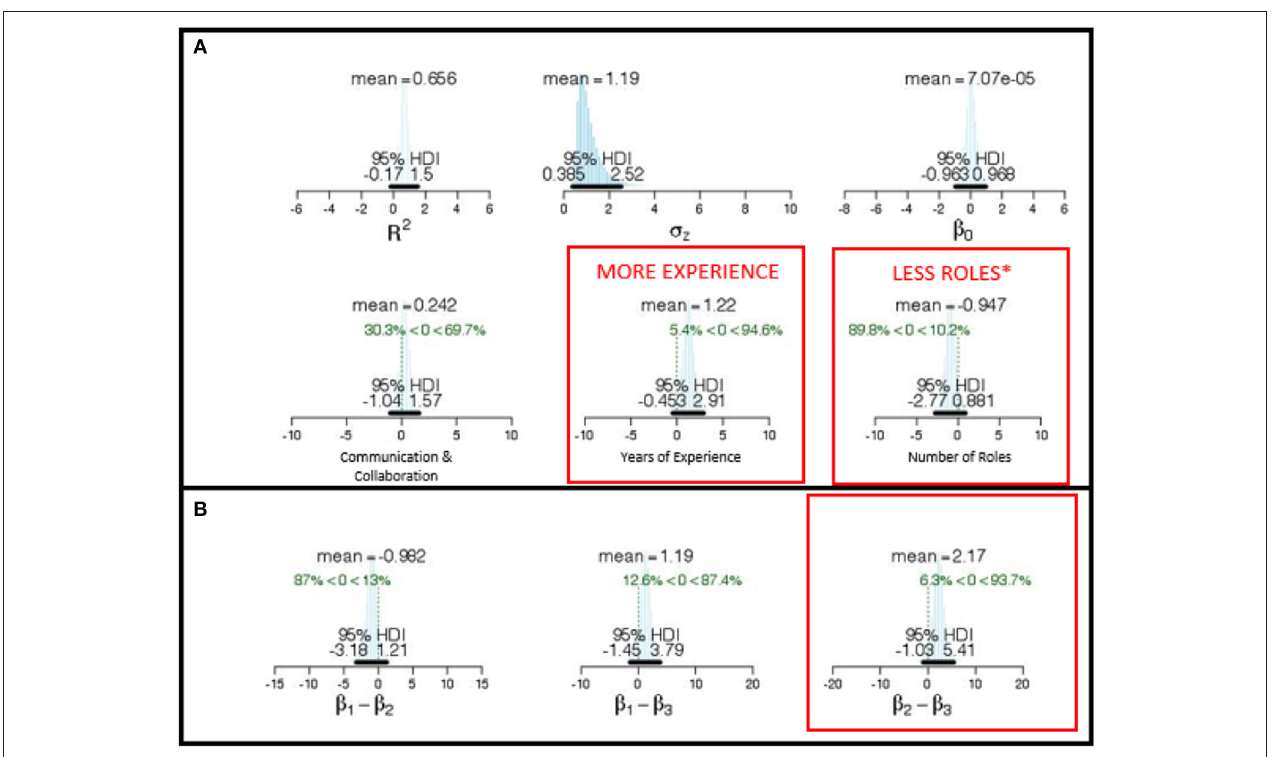
FIGURE 8 | (A) Posterior distributions of regression parameters for the simultaneous model predicting Incident Response score with β 1 (Communication and Collaboration Factor), β 2 (Leadership Factor), and β 3 (Number of Skill Roles) as predictors of team performance. Strong predictors indicated by red type. (B) Posterior distributions of difference among parameters indicates unique predictive quality of β 1 and β 3 to Incident Response scores.